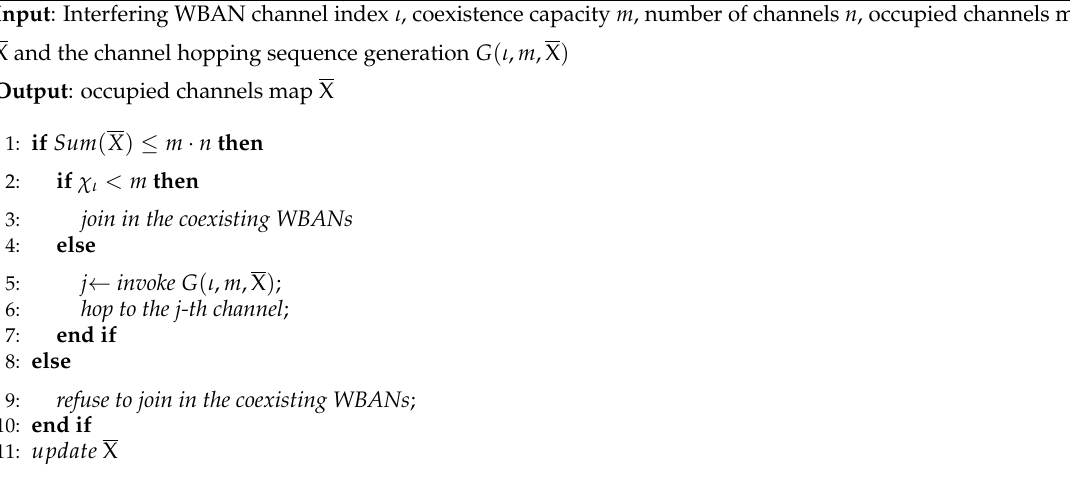
Algorithm 1 Joining process of enhanced channel hopping mechanism